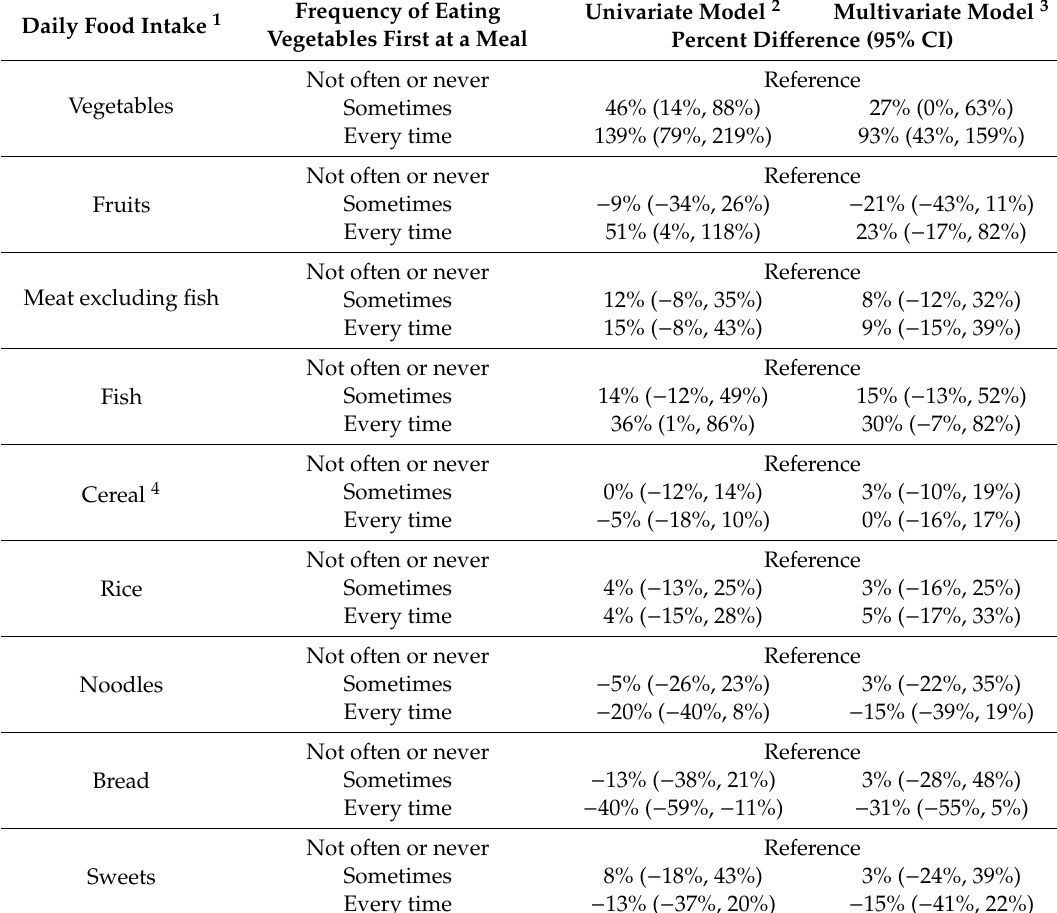
Table 3. Results on association between frequency of eating vegetables first at a meal and types of food intake 1